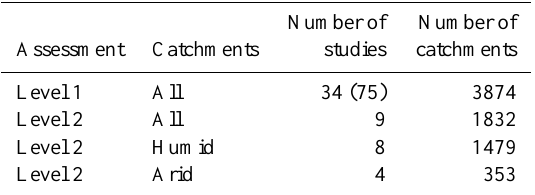
Table 2. Number of studies (in brackets number of results) and number of catchments used. Arid relates to catchments with an arid- ity index > 1, humid to those with an aridity index ≤ 1. Level 1 refers to an assessment of the average performance of studies, Level 2 to an assessment of the performance for individual catchments.